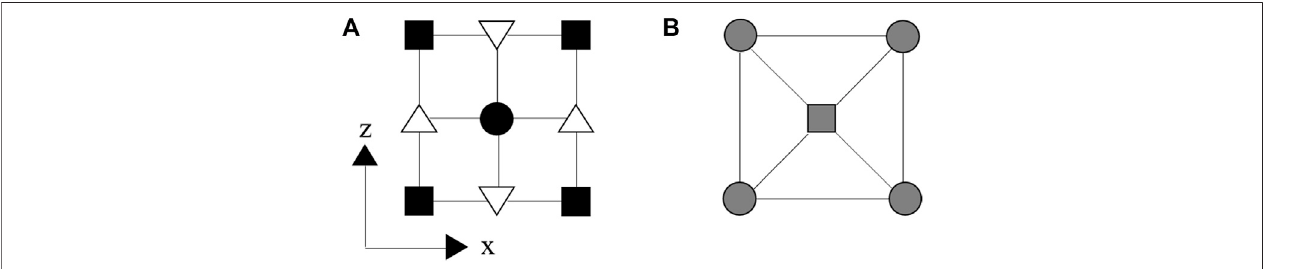
FIGURE 3 | Schematic diagram of fi nite difference operators for SSG (A) and RSG (B) . The SSG de fi nes normal stress and all physical parameters in the solid squares, and shear stress in the solid circle, but with horizontal and vertical velocities in the downward and upward triangles, respectively. The RSG de fi nes horizontal